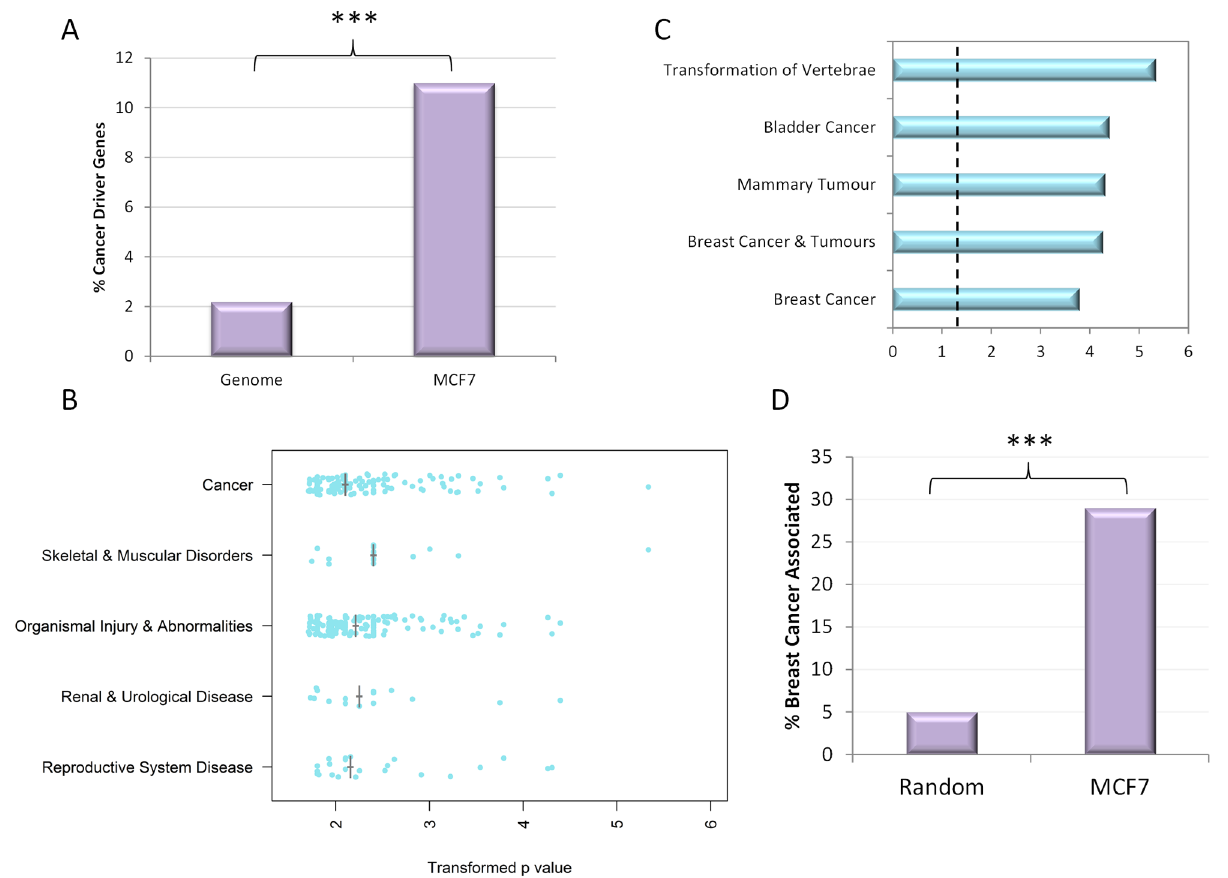
Fig 3. MCF-7 cancer association. A: Percentage of top 100 insertion gene clusters that are cancer driver genes compared to the genome as a whole. B: IPA top processes groupings showing the range of transformed p values, with median indicated by grey cross. C: Top 5 ‘ cancer ’ subtypes identified by IPA with transformed p value shown. Dotted line represents p = 0.05. D: Percentage of the top 100 insertion gene clusters with known breast cancer annotation as determined by systematic literature review compared to a random set of 100 genes.